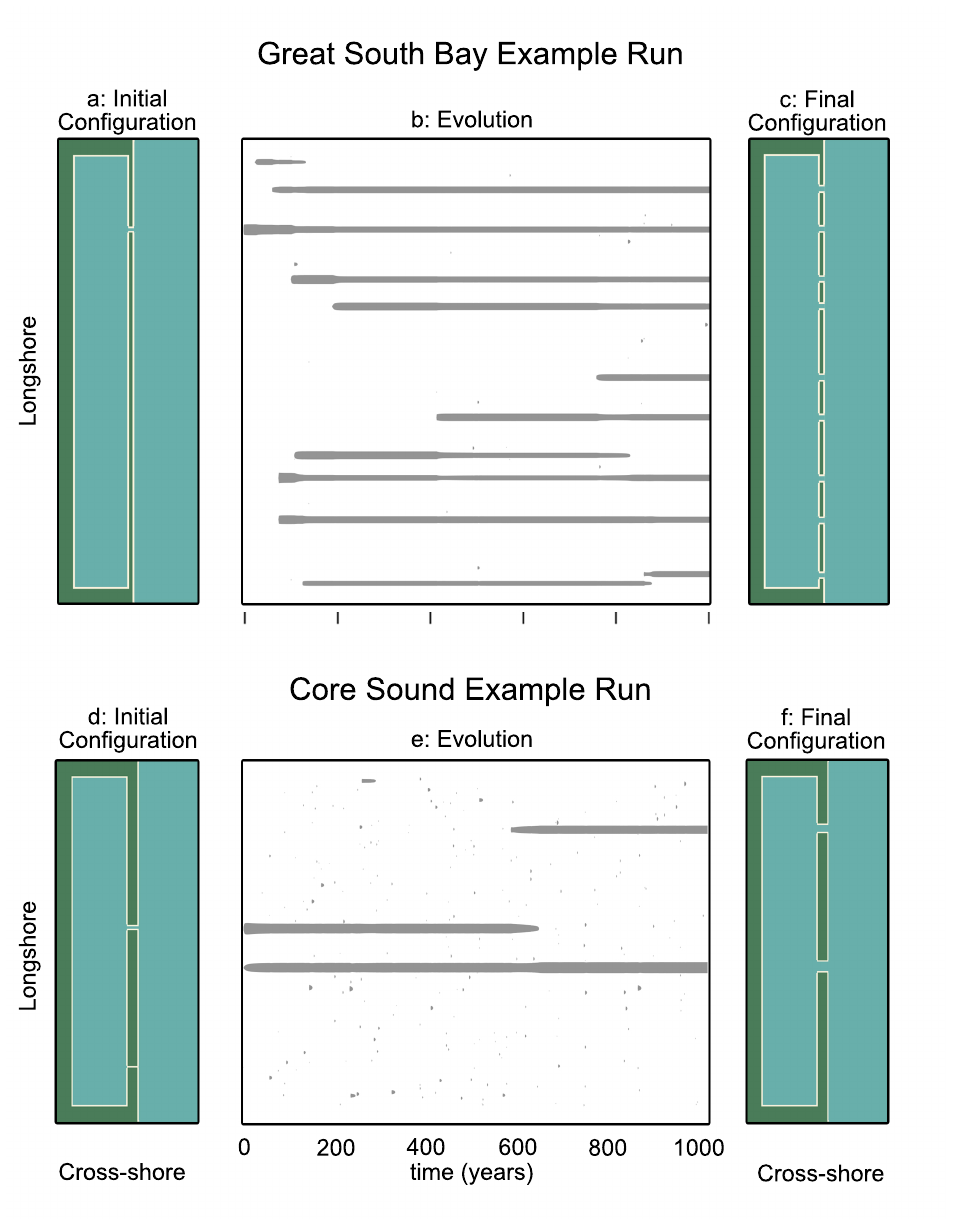
Figure 4. Two example runs for the sets of parameter values: Great South Bay (top), Core Sound (bottom). Shown are: the initial configuration with one open inlet ( a , d ); evolution of the system during which storm-induced breaches are stochastically forced ( b , e ); the final configuration with multiple open inlets ( c , f ). Please note that the grey dots correspond to breaches that quickly close after being randomly